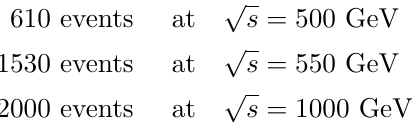
Figure 9 . The (cid:20) value which reproduces the SM ( h = H ) cross section for (cid:24) htt htt p s = 500 GeV (black solid), 550 GeV (red dotted) and 1000 GeV (green dashed). The results are for (cid:20) = hZZ